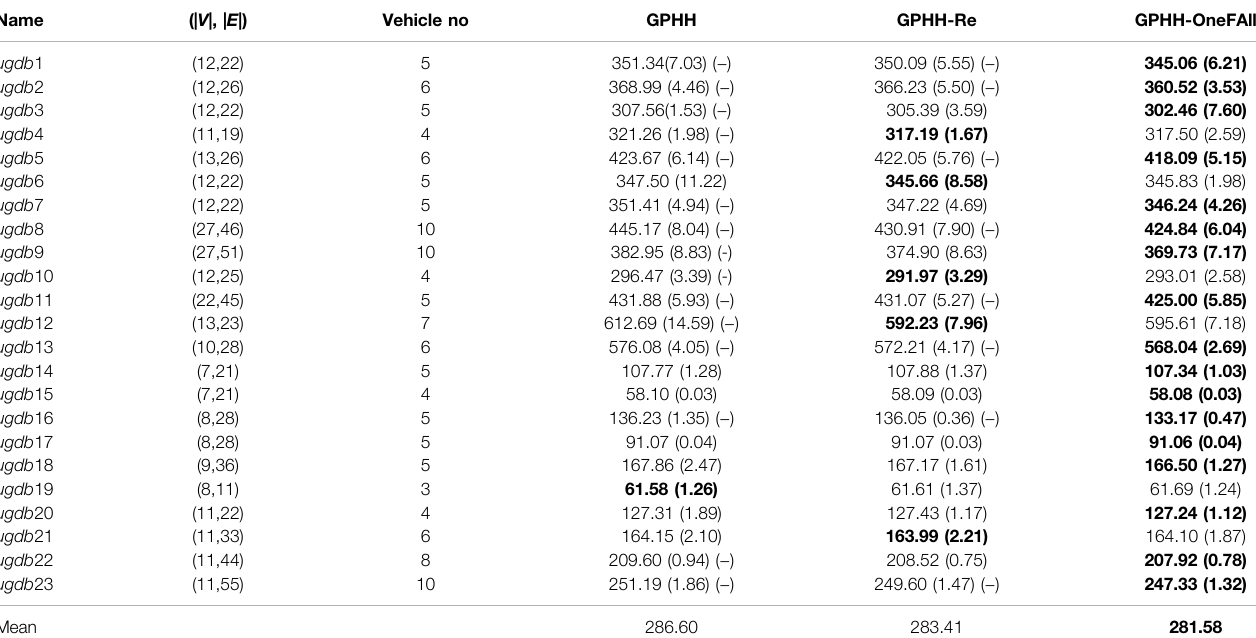
TABLE 3 | Results on the ugdb dataset in terms of the average on the test set. Name